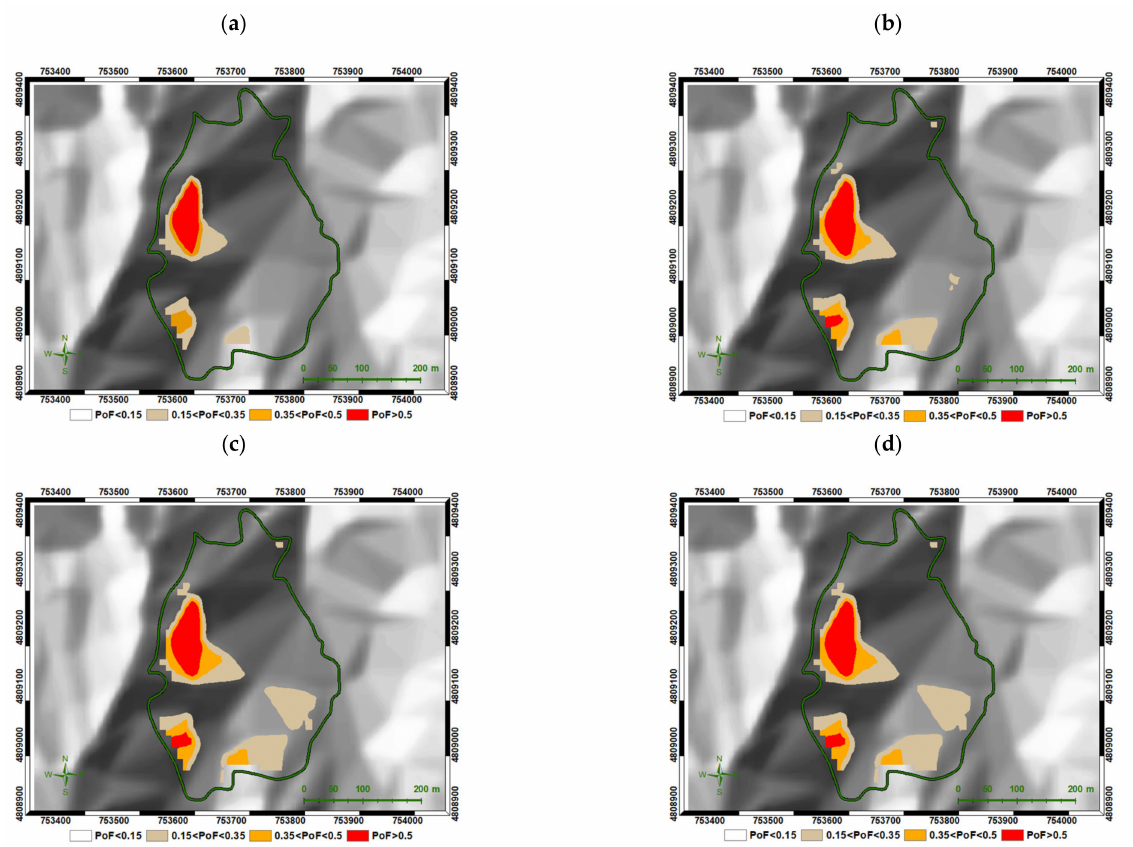
Figure 5. Maps of the probability of failure (PoFr) computed considering the pdf defined in Table 1 for the random variables in input in the PB model. ( a ) td = 8 h; ( b ) td = 16 h; ( c ) td = 24 h; ( d ) td = 32